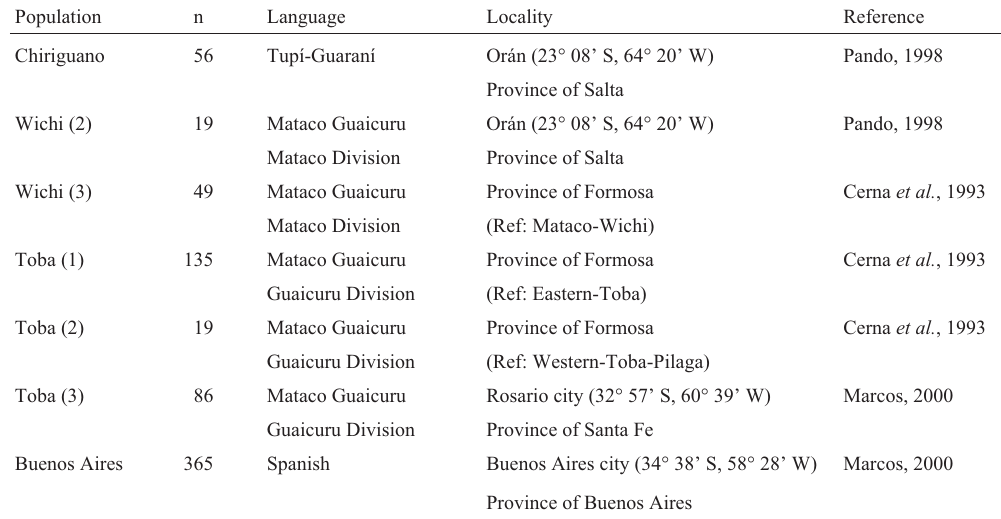
Table 2 - Geographic and linguistic origins of the Argentinean populations that were compared with the Amerindian groups studied.